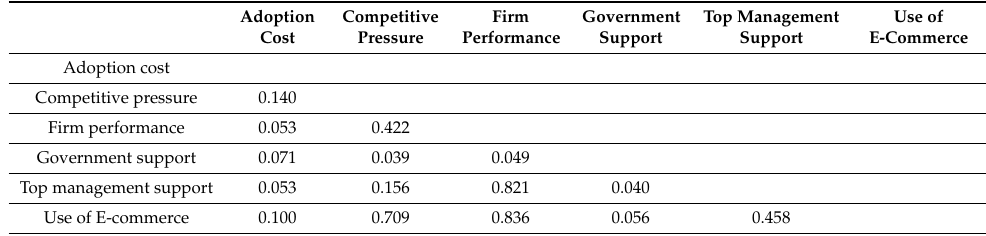
Table 9. Heterotrait-monotrait ratio of correlations